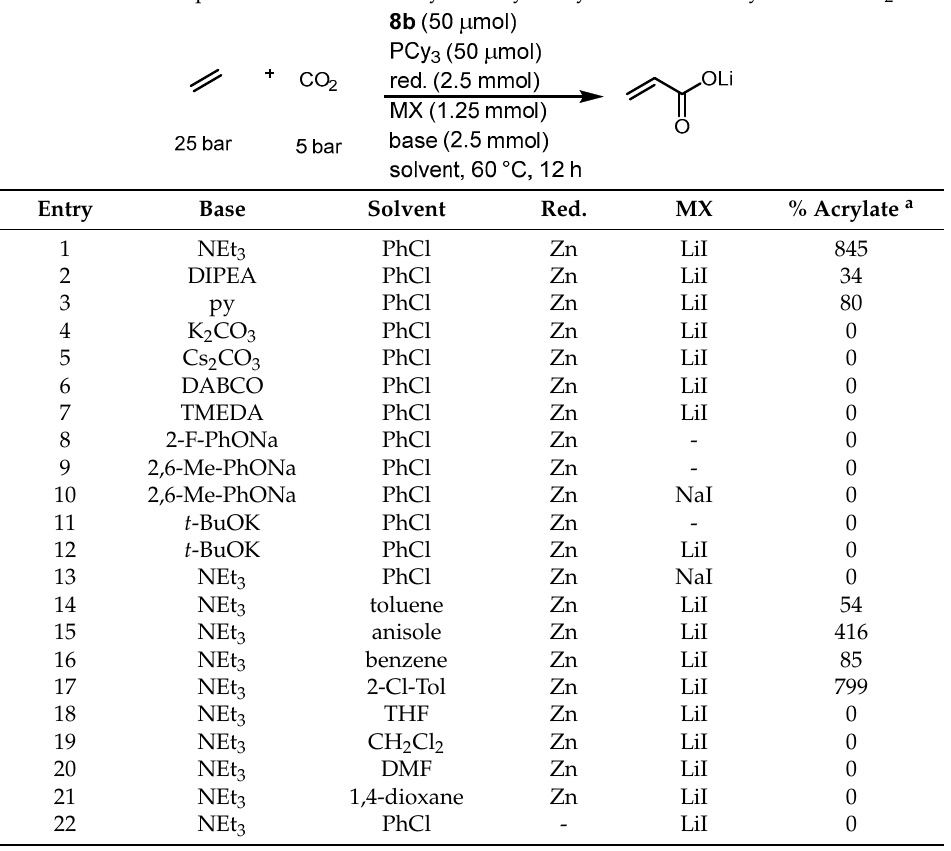
Table 2. Reaction optimization for Ni-catalyzed acrylate synthesis from ethylene and CO 2 .